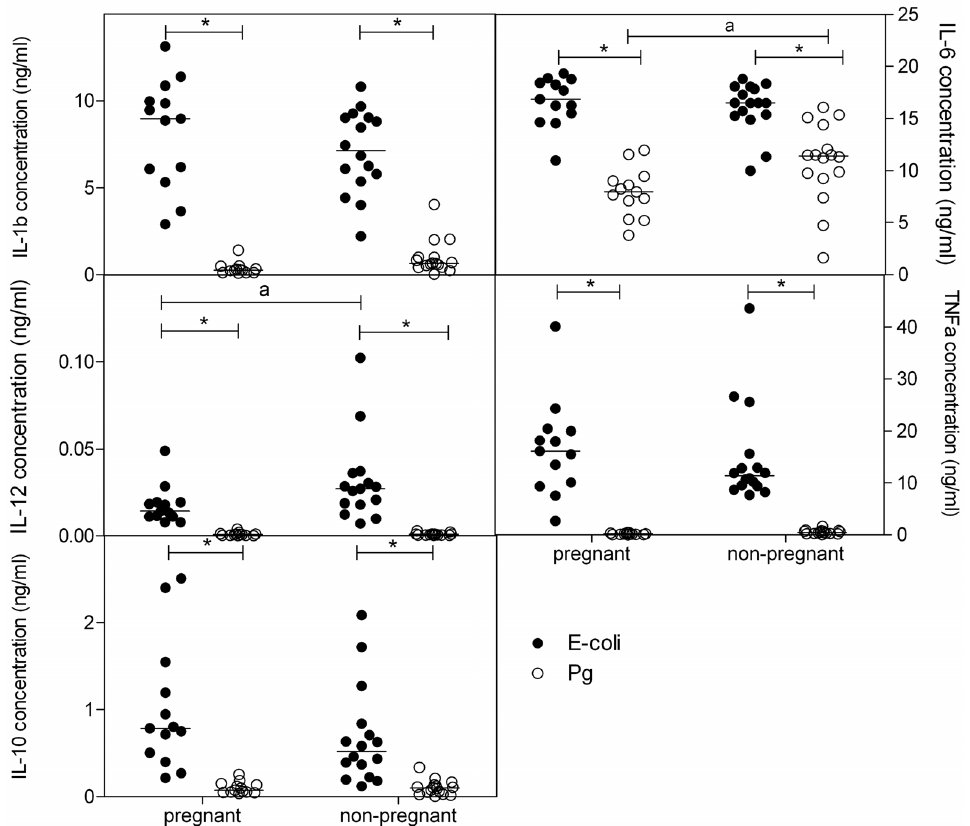
Figure 2. Cytokine concentrations following stimulation with bacteria. Concentrations (ng/ml) of IL-1b, IL-6, IL-12, TFN a and IL-10 in plasma of pregnant and non-pregnant women following stimulation of whole blood with E-coli (black dots) or P. Gingivalis (PG) (open dots) bacteria (5*10 7 bacteria/ml) for 24 hr. *significantly different from E-coli (two-way ANOVA followed by Bonferroni post-tests, p , 0.05)). a: significantly different from pregnant women after the same stimulation (two-way ANOVA followed by Bonferroni post-tests, p , 0.05).